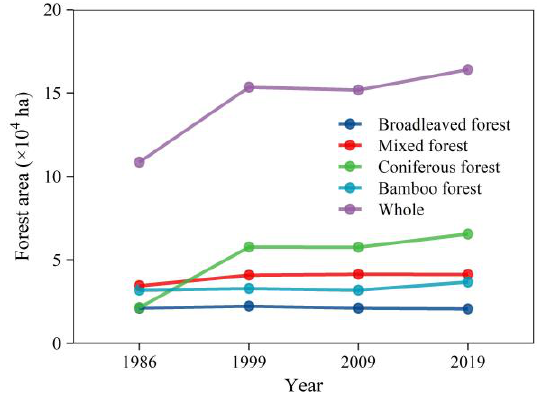
Figure 4. Area changes in different forest types in Taihe County from 1986 to 2019.